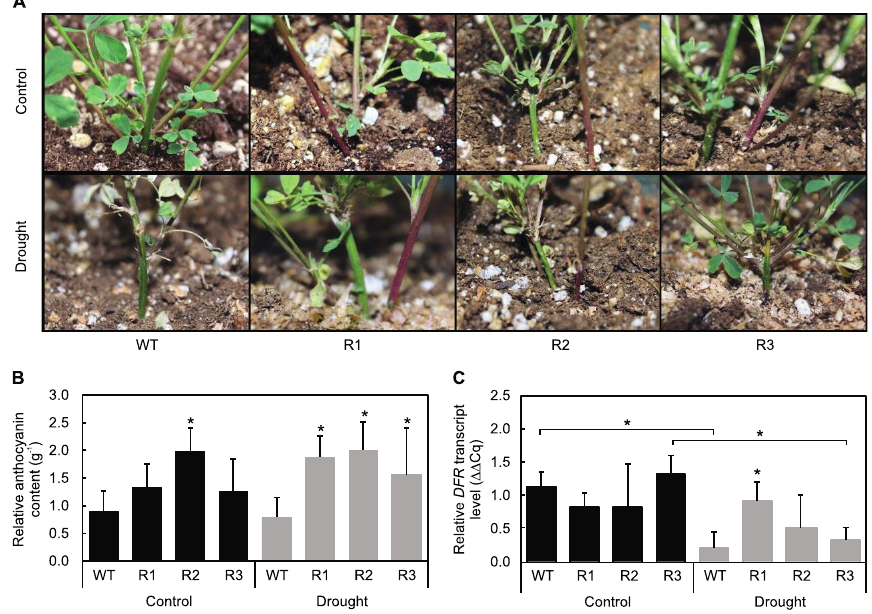
Figure 8. MsSPL9 role in anthocyanin biosynthesis: ( A ) stem base phenotypes after 12 days of control and drought conditions, ( B ) relative anthocyanin content extracted from alfalfa stems ( n = 10), and ( C ) dihydroflavonol 4-reductase (DFR) transcript abundance in alfalfa stems ( n = 2–5). The asterisks indicate significant differences within treatments (Dunnett’s test), and the bars indicate significant differences between treatments (Sidak test) in a two-way ANOVA where p < 0.05.